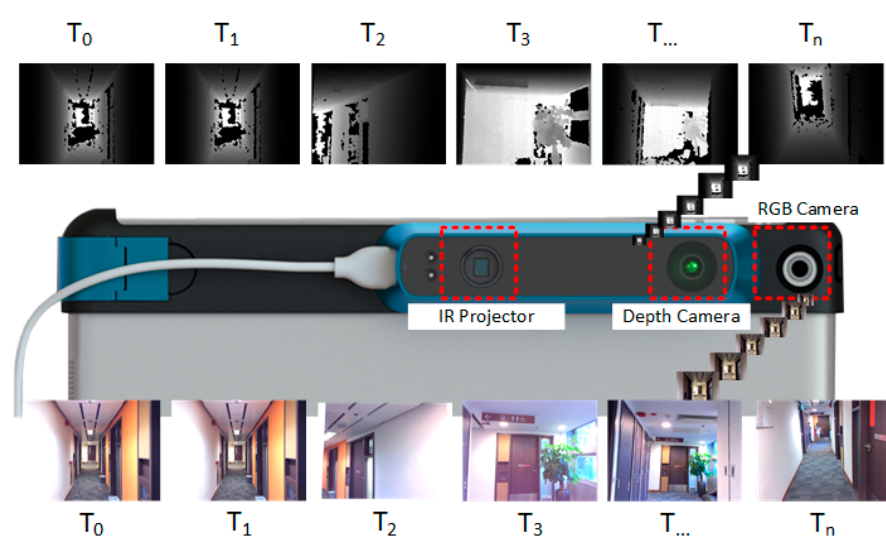
Figure 1. Hardware scheme of the RGB-D sensor and the acquired RGB-D sequences.